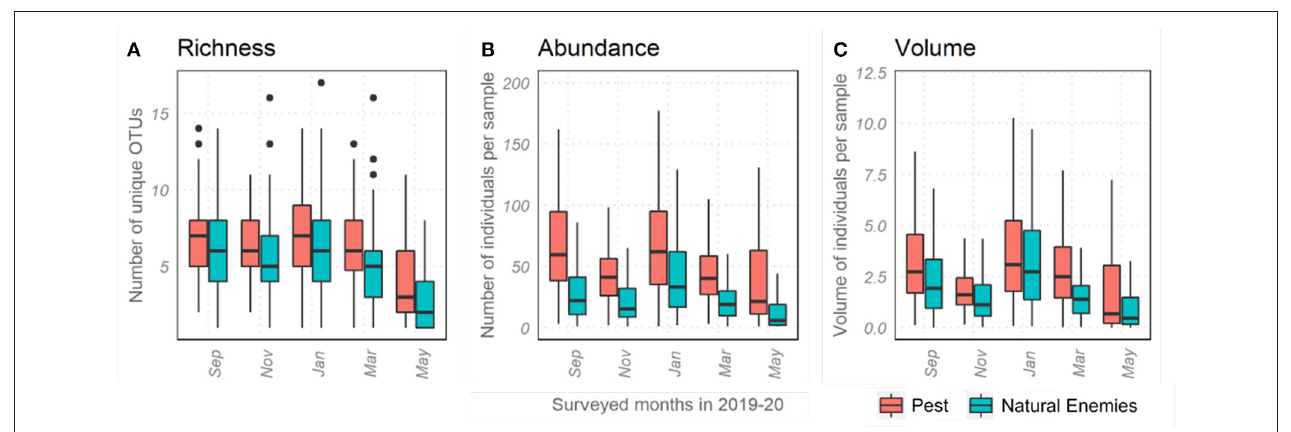
FIGURE 3 | Effect of sampling month on invertebrate richness (A) abundance (B) and volume (C) . November showed significantly reduced abundance and volume, which also correlated with flash floods in the study area.